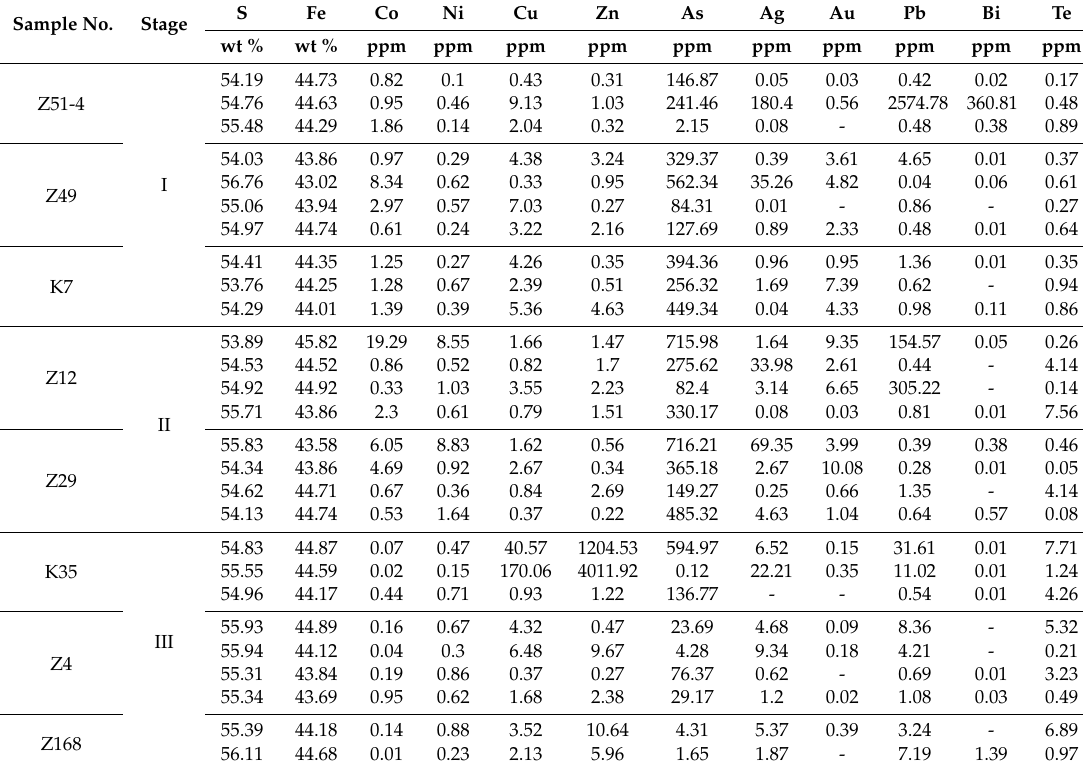
Table 4. LA-ICP-MS spot analysis of pyrite